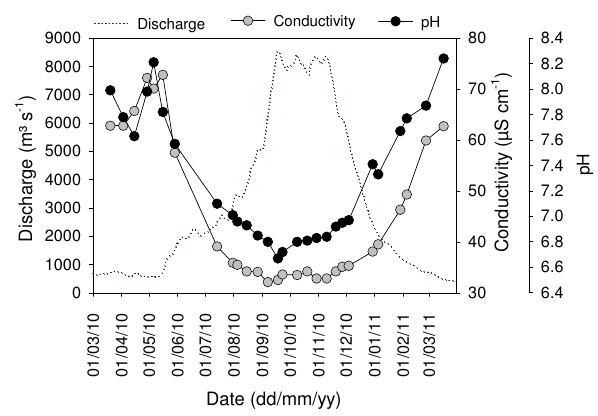
Fig. 2. Daily discharge data (dotted line) for the period March 2010–March 2011, and measured conductivity (grey symbols) and pH (black symbols) in the Oubangui River at